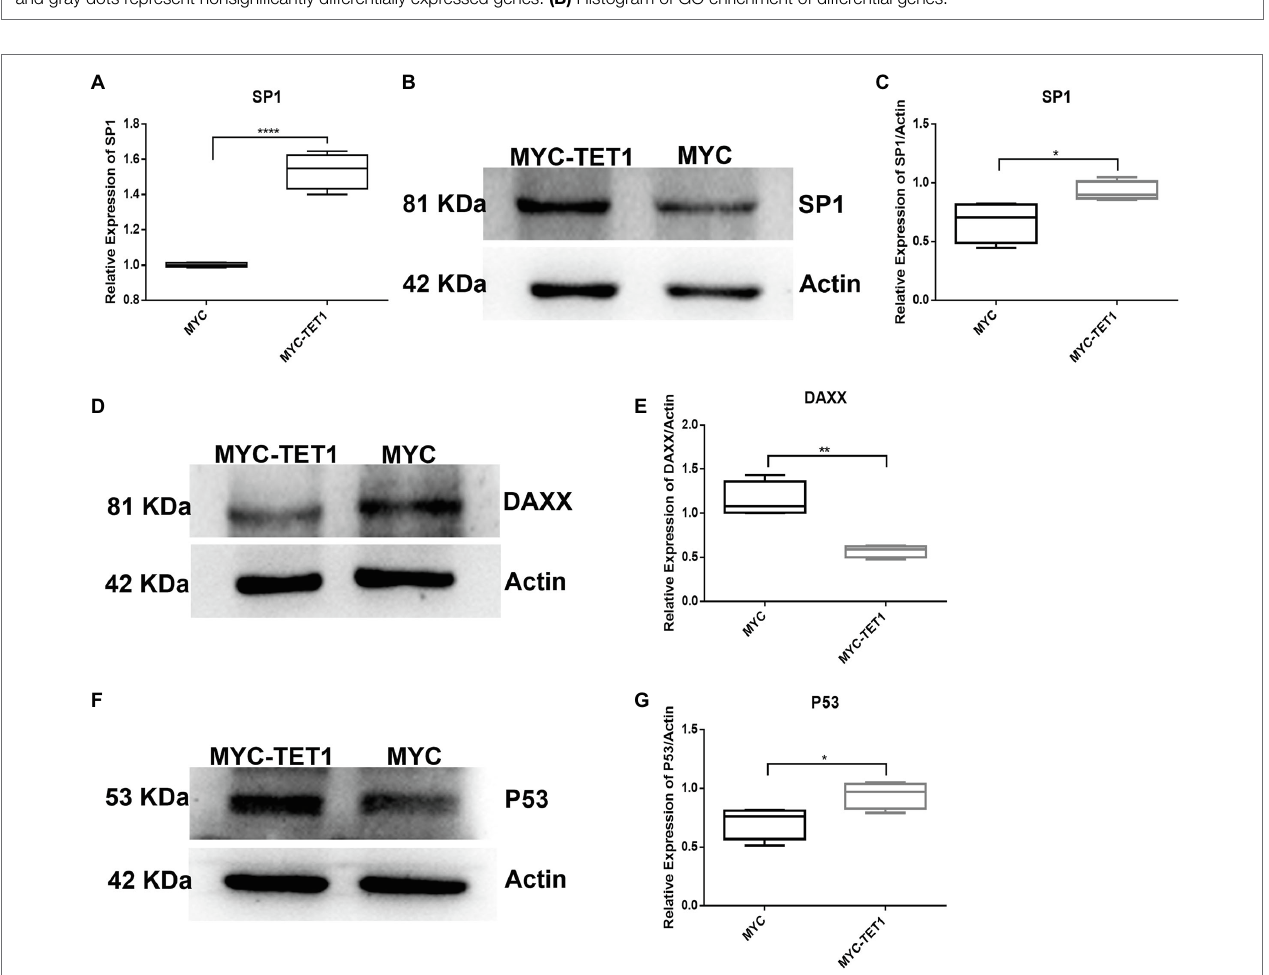
FIGURE 5 | mRNA and protein levels of TET1 and MYC-TET1 cells were detected. (A) The mRNA expression of SP1 in spermatogonial cells was detected by QRT-PCR. (B) The expression of SP1 in TET1 overexpressed cells was detected by Western Blot. (C) Quantification of SP1 protein levels in TET1 overexpressed cells. (D) The expression of DAXX in TET1 overexpressed cells was detected by Western Blot. (E) Quantification of DAXX protein levels in TET1 overexpressed cells. (F) The expression of P53 in TET1 overexpressed cells was detected by Western Blot. (G) Quantification of P53 protein levels in TET1 overexpressed cells. p < .0001(****), p < .001(***), p < .01(**), p <